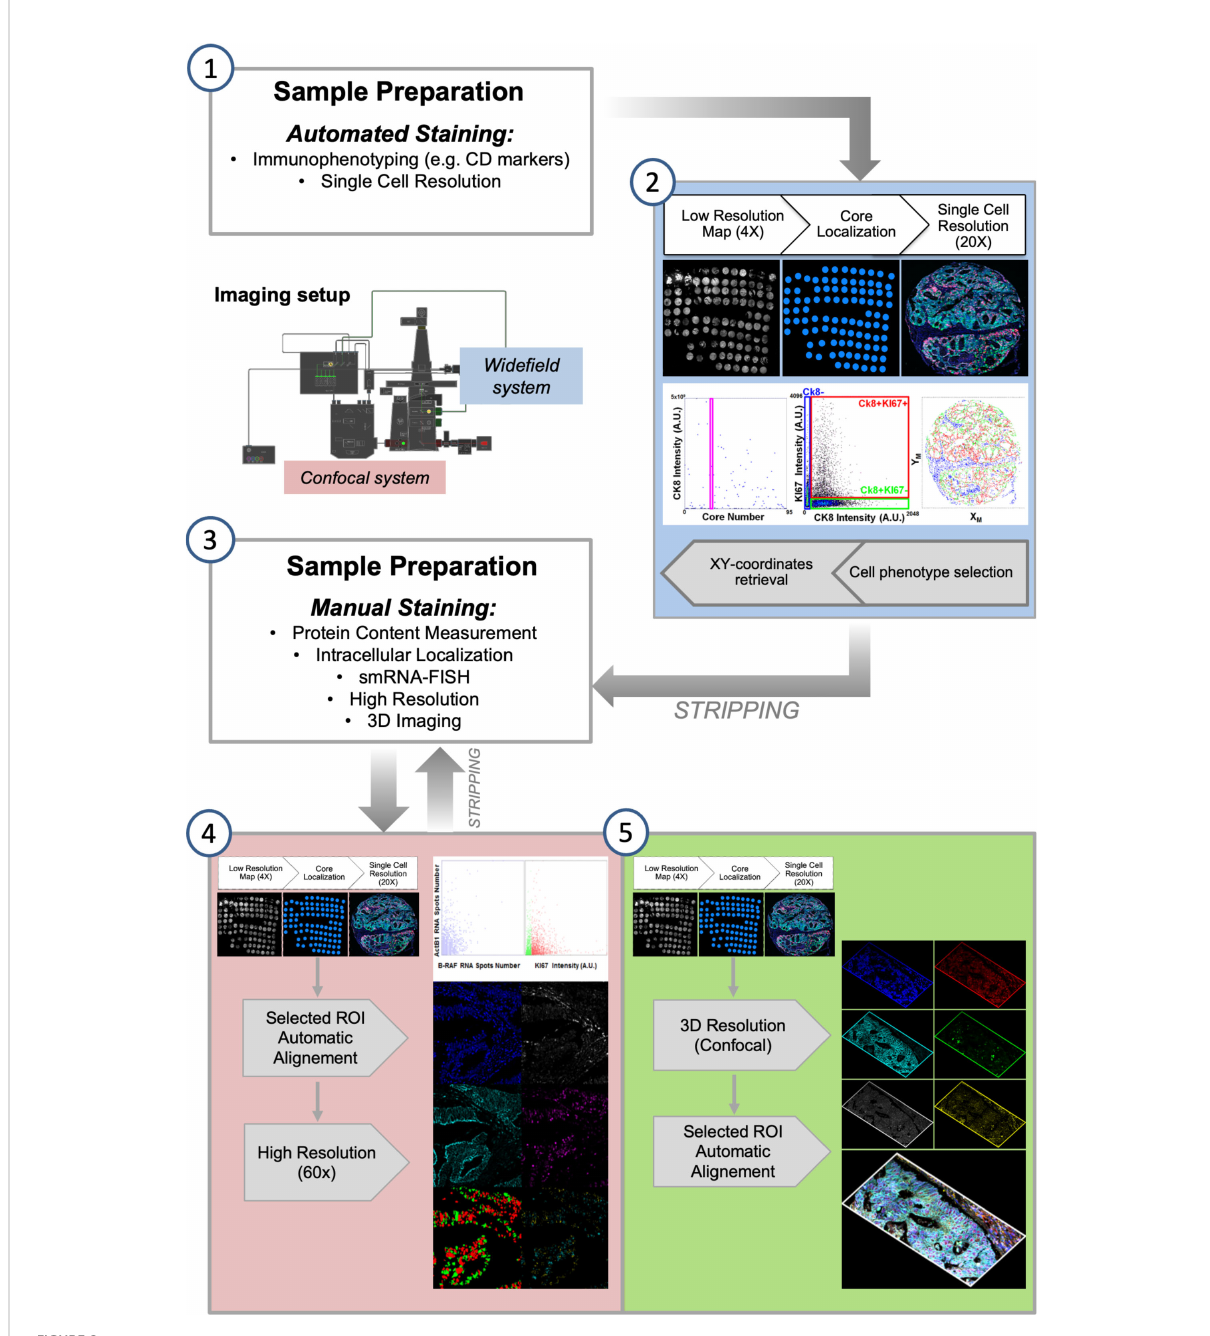
FIGURE 2 Semi-automated Multi-Modal Multi-Resolution Work fl ow for Multiplexing Experiments. (1) Samples are processed with an automated stainer for detection of highly expressed population-marking antigens. (2) Images are collected by an automated fl uorescence microscopy workstation following an analysis-driven protocol that allows automatic selection and acquisition and processing of single cell-resolution data. Steps (1-2) can be iterated for some cycles by stripping bound antibodies. (3) Immuno-staining is performed at the bench to allow high sensitivity and resolution detection of selected biomarkers. (4) Diffraction limited and (5) 3D confocal analysis is performed on targeted regions calculated from the analysis of the cell-resolved data from step (2). Steps (4-5) can be iterated for some cycles by stripping bound